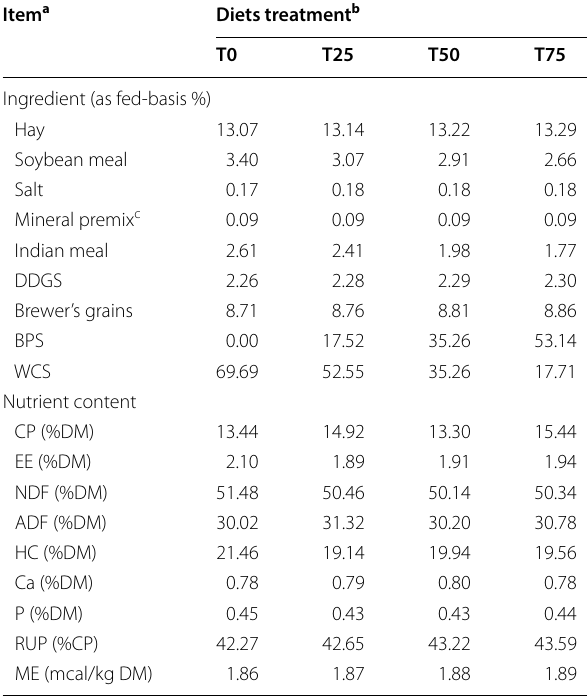
Table 2 Ingredients and chemical composition of the